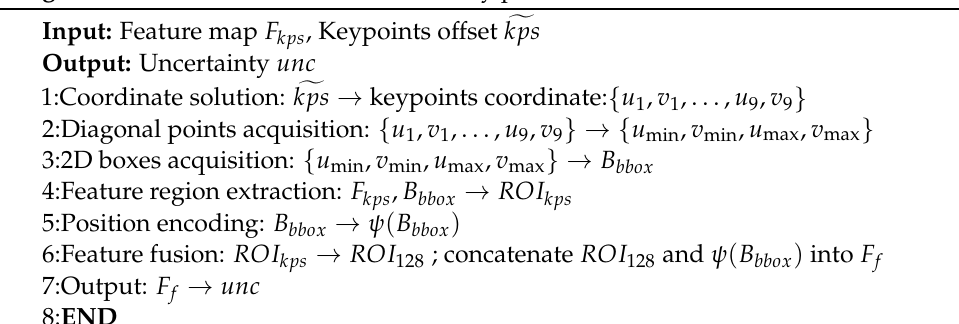
Algorithm 1: The illustration of uncertainty